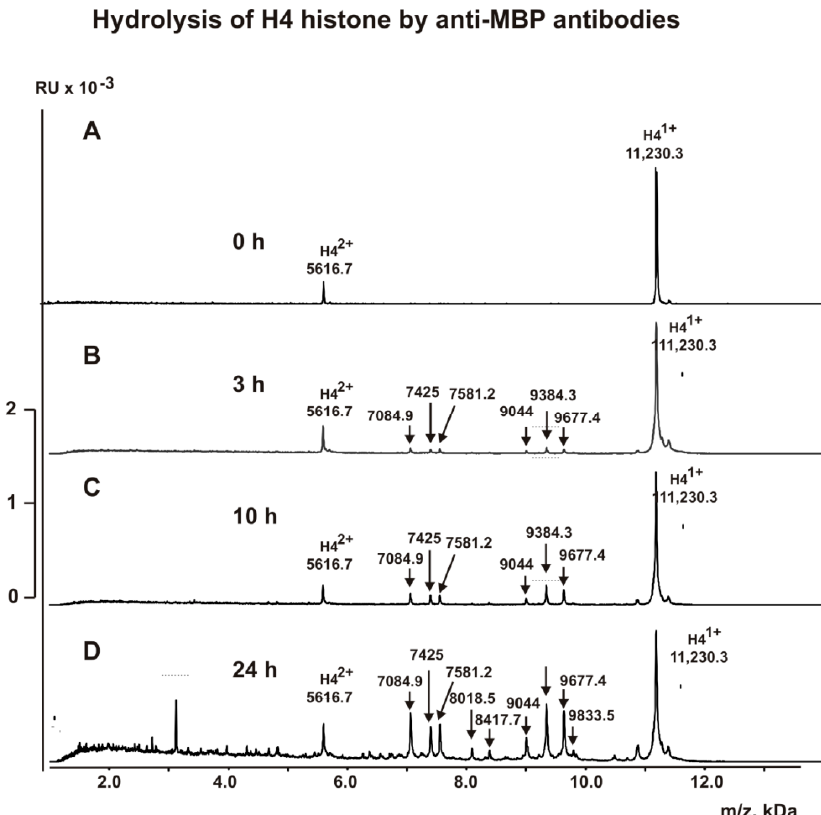
Figure 4. Complete sequence of H3 and H4 histones: all sites of H3 cleavage by anti-MBP ( A ) and anti-H3 histone IgGs ( B ) as well as H4 histone sites of cleavage with anti-MBP ( C ) and anti-H4 histone IgGs ( D ). Major sites of the cleavage are marked shown by double arrows ( ↕ ), moderate ones by arrows ( ↓ ), and minor sites of the hydrolysis by stars (*) ( A – D ). Molecules 2021 , 26 , x 10 of 23